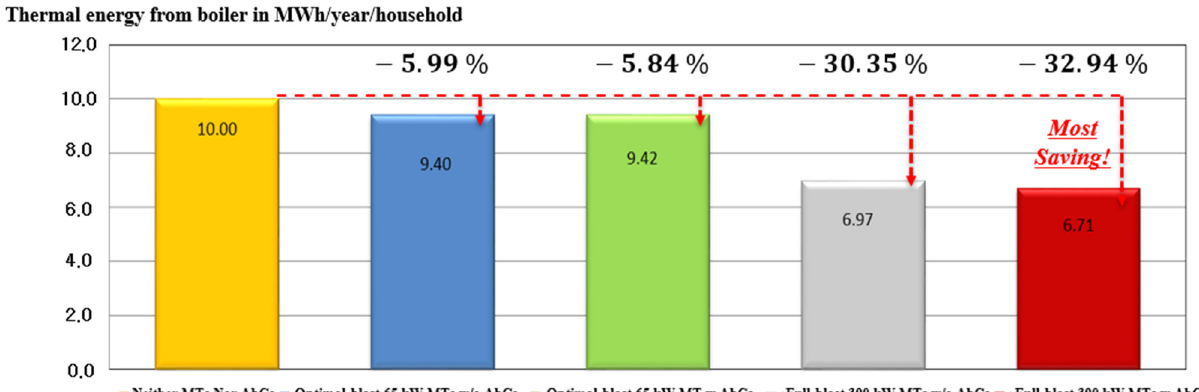
Figure 12. Electrical energy consumption from the grid (scenario 2).